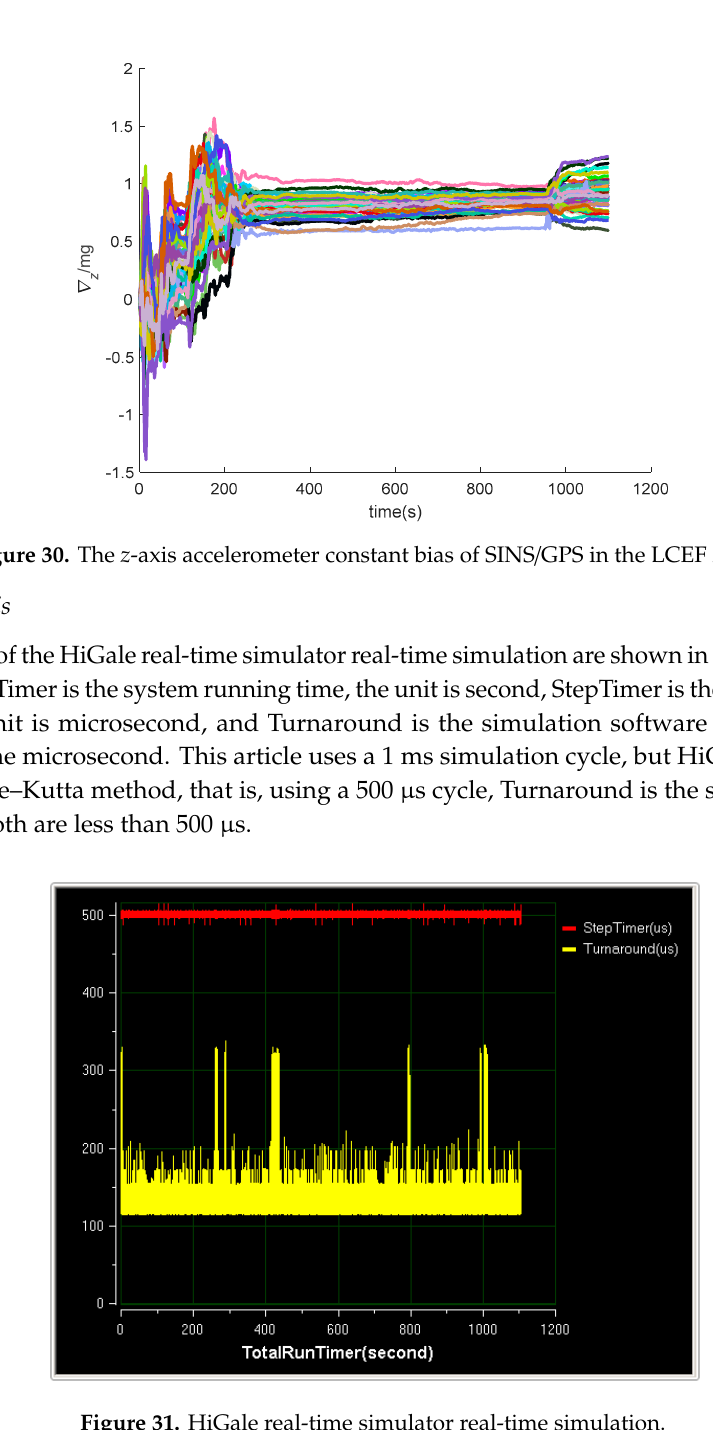
Figure 29. The y -axis accelerometer constant bias of SINS/GPS in the LCEF frame.